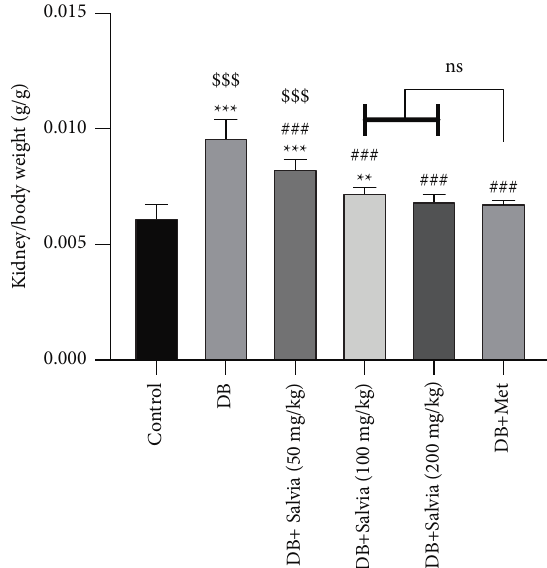
Figure 2: Effect of Salvia spinosa extracts on kidney/body weight coefficient in streptozotocin-induced diabetic mice. Control: normal mice, DB: diabetic mice, DB+Salvia: diabetic mice given the methanolic extract of Salvia spinosa , and DB +Met: diabetic mice given metformin (500 mg/kg). Values represented as mean ± SD. ∗∗ P < 0 . 01 compared with control mice, ∗∗∗ P < 0 . 001 compared with control mice, ### P < 0 . 001 compared with diabetic mice. $$$ P < 0 . 05 compared with metformin-treated diabetic mice. Ns: